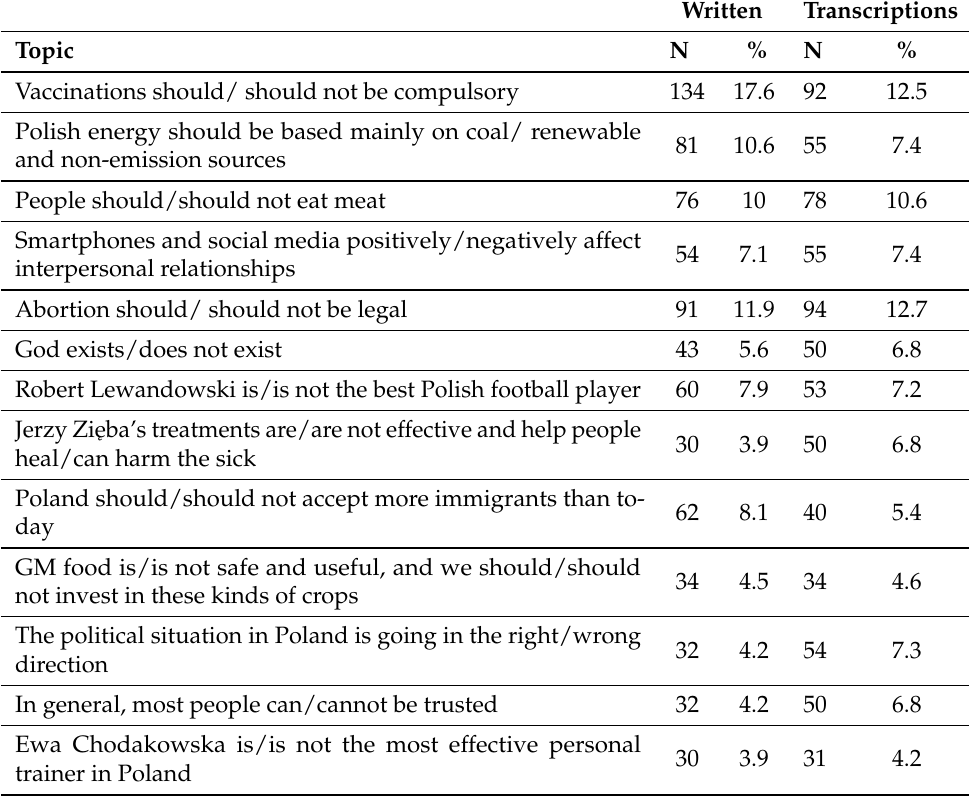
Table 1. Number of statements by